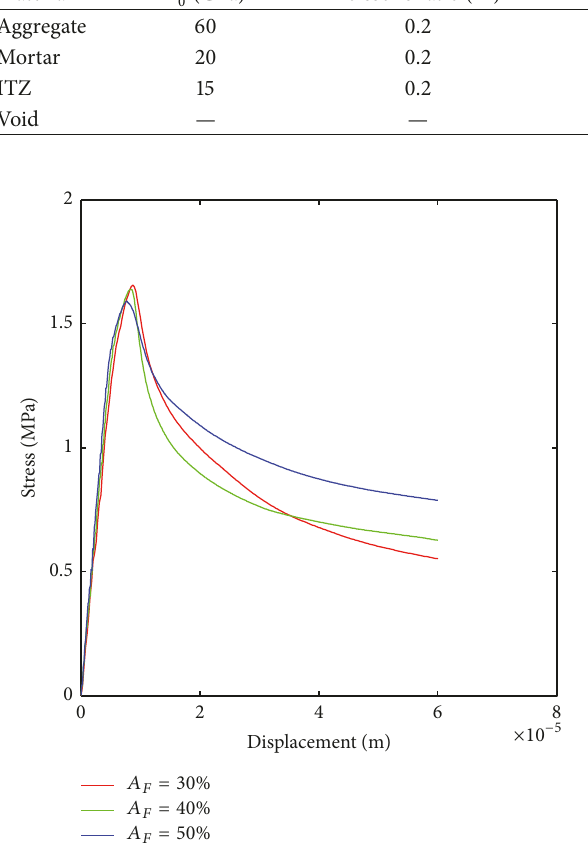
Figure 11: Stress-displacement curves of different aggregate volume